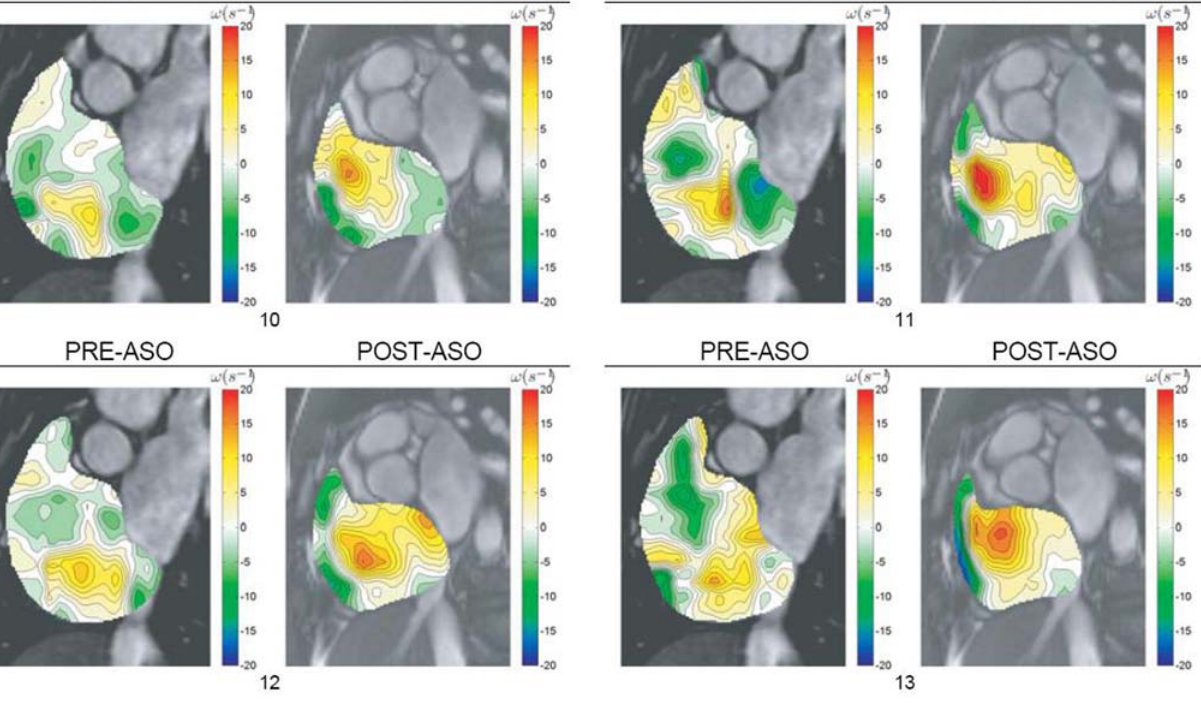
Figure 4. Vorticity visualization of right atrial flow pre- and post-ASO. Vorticity contour maps are superimposed onto cardiac MR images and presented. The vorticity representation by the flow map in color codes can be referenced against scales (in metric units of per second) on the right hand side. The range of the vorticity given by v Min to v Max is stated below each result set with the subscripts 1 and 2 representing pre- and post-ASO conditions